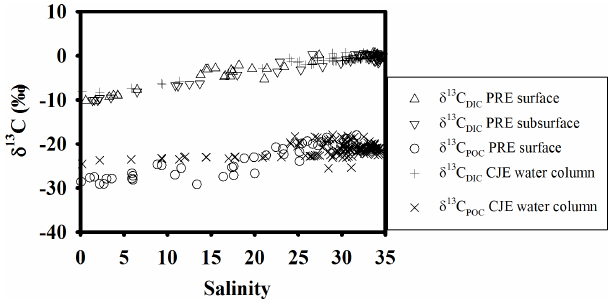
Figure 5. Distribution of δ 13 C DIC and δ 13 C POC with respect to salinity in the PRE. The upward- and downward-facing triangles denote surface and subsurface δ 13 C DIC data, respectively, from July 2014, while the open circles represent δ 13 C POC values in surface water from July 2015. Additionally, the plus signs and crosses show the δ 13 C DIC and δ 13 C POC data, respectively, from the Changjiang Estuary (CJE) in Wang et al. (2016).